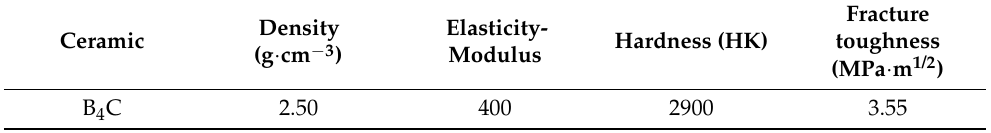
Table 1. Physical properties of boron